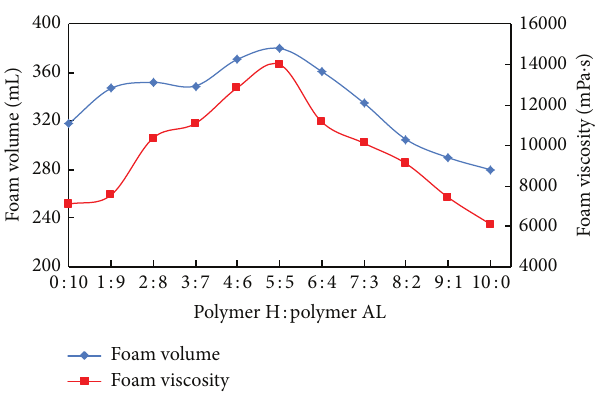
Figure 2: The influence of mixed ratio on gelation of foamed gel.